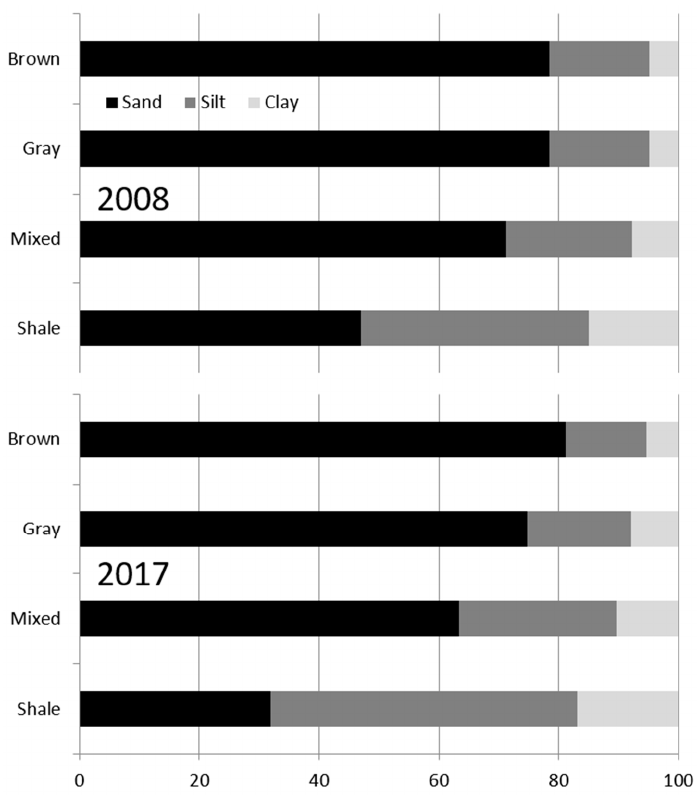
Figure 2. Shifts in soil particle size distribution across spoil types from 2008 to 2017 (2008 data from Miller et al. [12]).